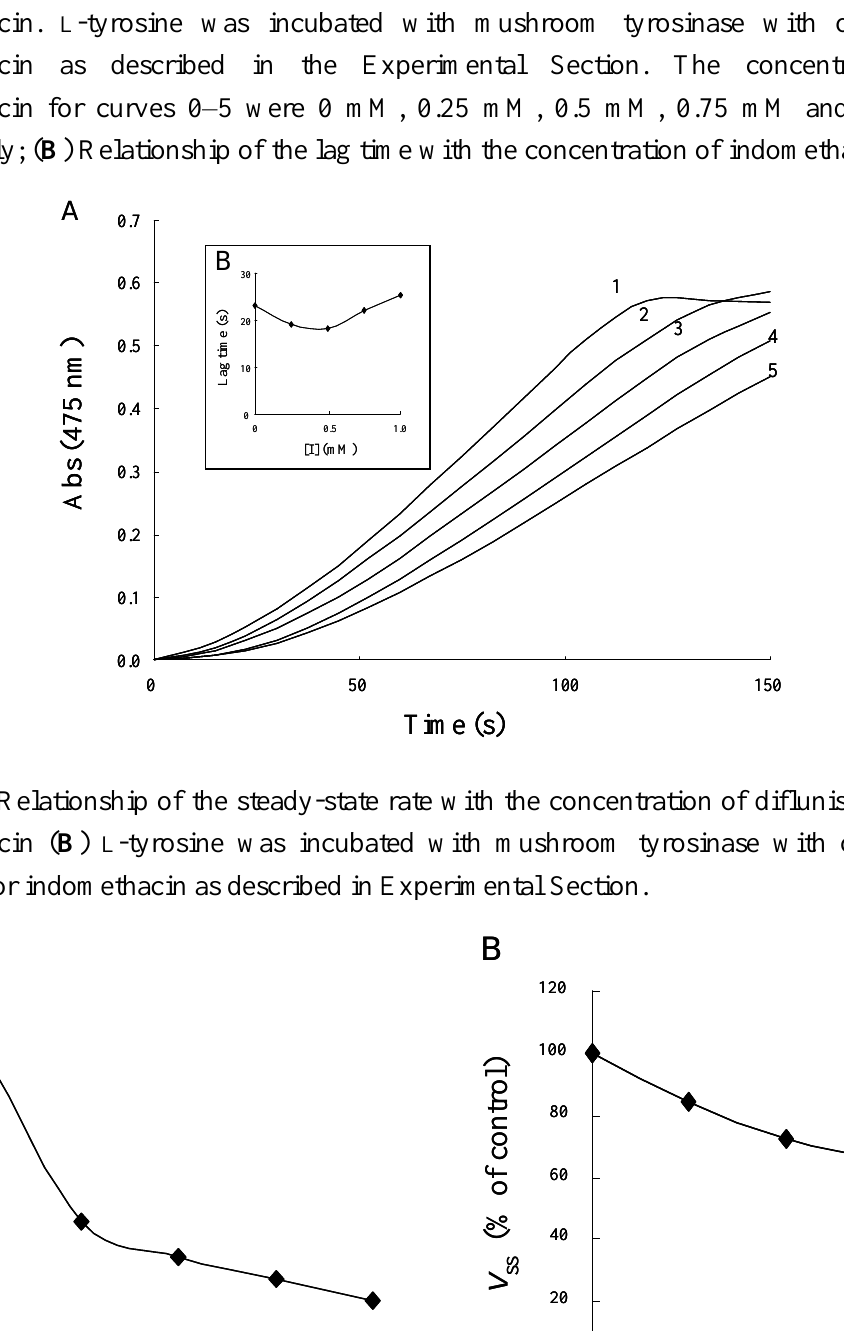
Figure 3. ( A ) Progress curves for the inhibition of monophenolase activity of tyrosinase by indomethacin. L -tyrosine was incubated with mushroom tyrosinase with or without indomethacin as described in the Experimental Section. The concentrations of indomethacin for curves 0–5 were 0 mM, 0.25 mM, 0.5 mM, 0.75 mM and 1.0 mM, respectively; ( B ) Relationship of the lag time with the concentration of indomethacin.